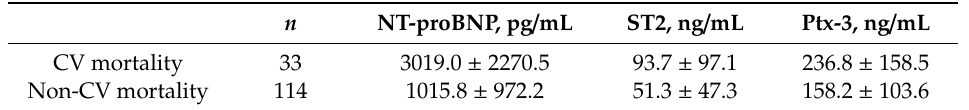
Table 5. Concentration of biomarkers in CV mortality/non-CV mortality subgroups in a two-year FU after STEMI presented as mean with SD.